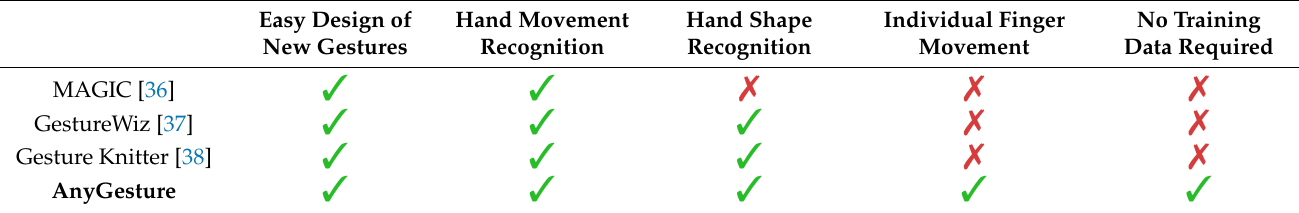
Table 1. Comparison and differentiation with similar systems in existing literature. All mentioned systems have the aim of allowing the rapid design of new gestures. AnyGesture is the only system that does not require multiple training samples and allows gestures that involve individual finger movements. The green check mark indicates availability, the red cross no availability. Easy Design